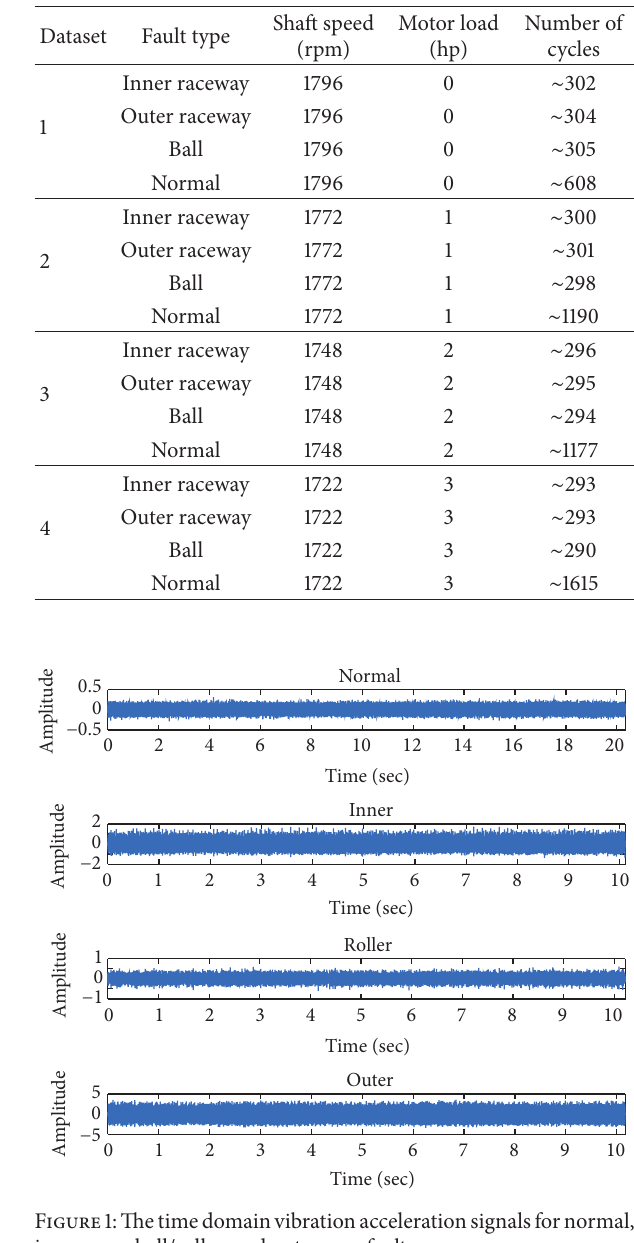
is ∼ 406 samples; for the 1748 rpm dataset, it is ∼ 412 samples; and for the 1722 rpm dataset, it is ∼ 418 samples). These slices are then stacked over each other to construct the grayscale vibration images. The heights of these images correspond to the number of slices that are stacked during their construc- tion. The details of this process and the motivation for it are discussed in detail in Section 3. The raw vibration acceleration signals are first converted into grayscale images, which are then used for extracting microtexture information using the local binary